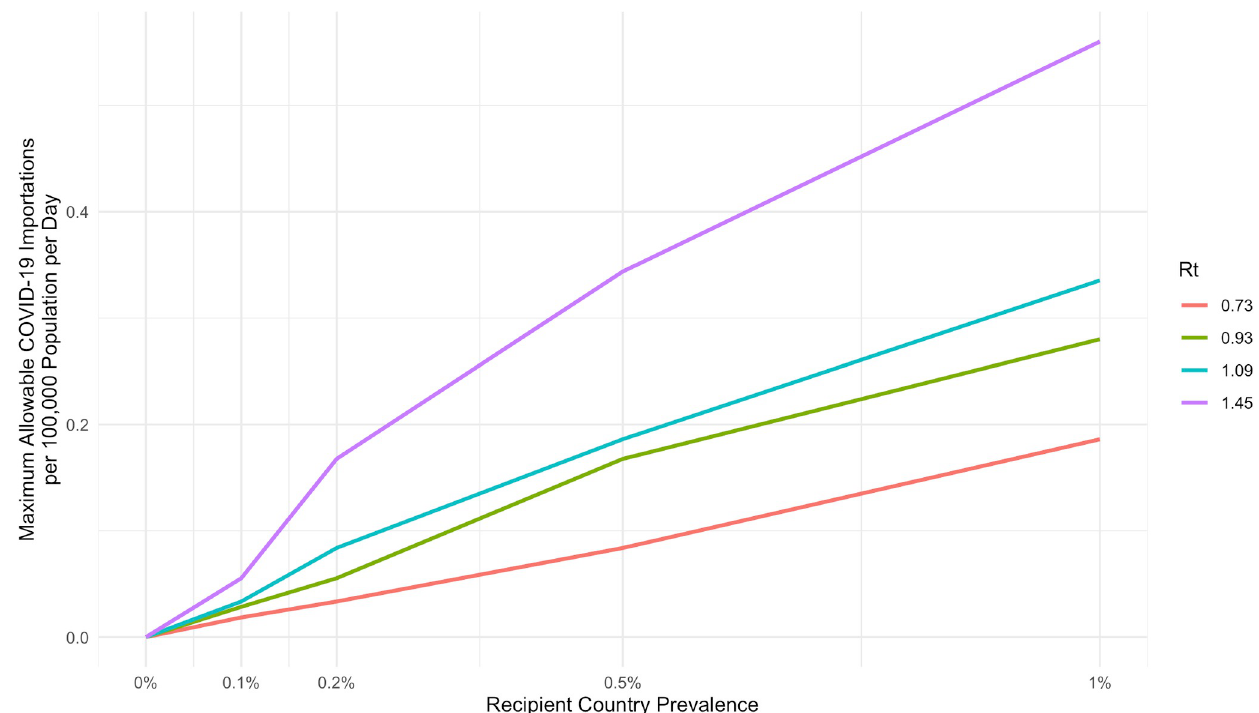
Fig 6. Maximum allowable daily COVID-19 case importations varied by recipient country prevalence and the effective reproductive number at time t .